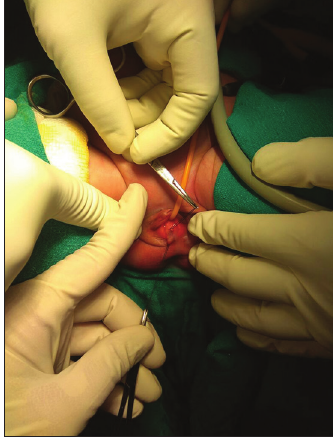
Figure 2: Drainage of mucoid